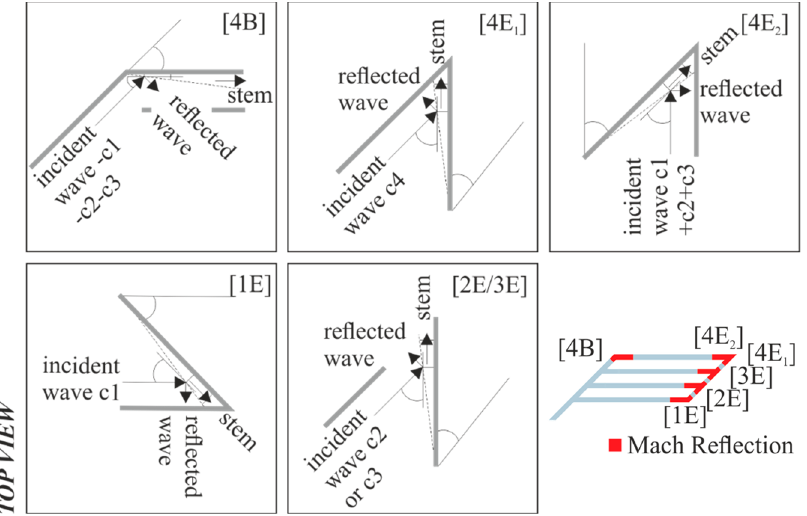
Figure 5. Mach reflection points in the branched channel system, before backflow.